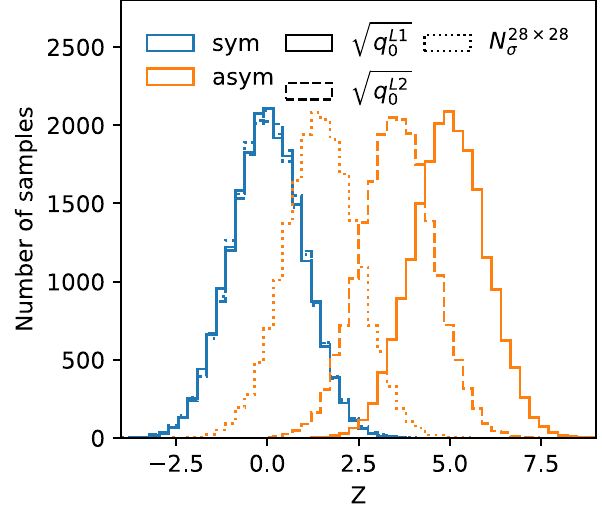
Fig. 2 Significance PDFs comparing results of the N σ , q L 1 tests for the Higgs LFV example, with injected signal strength corre- sponding to 5 σ of q L 1 0